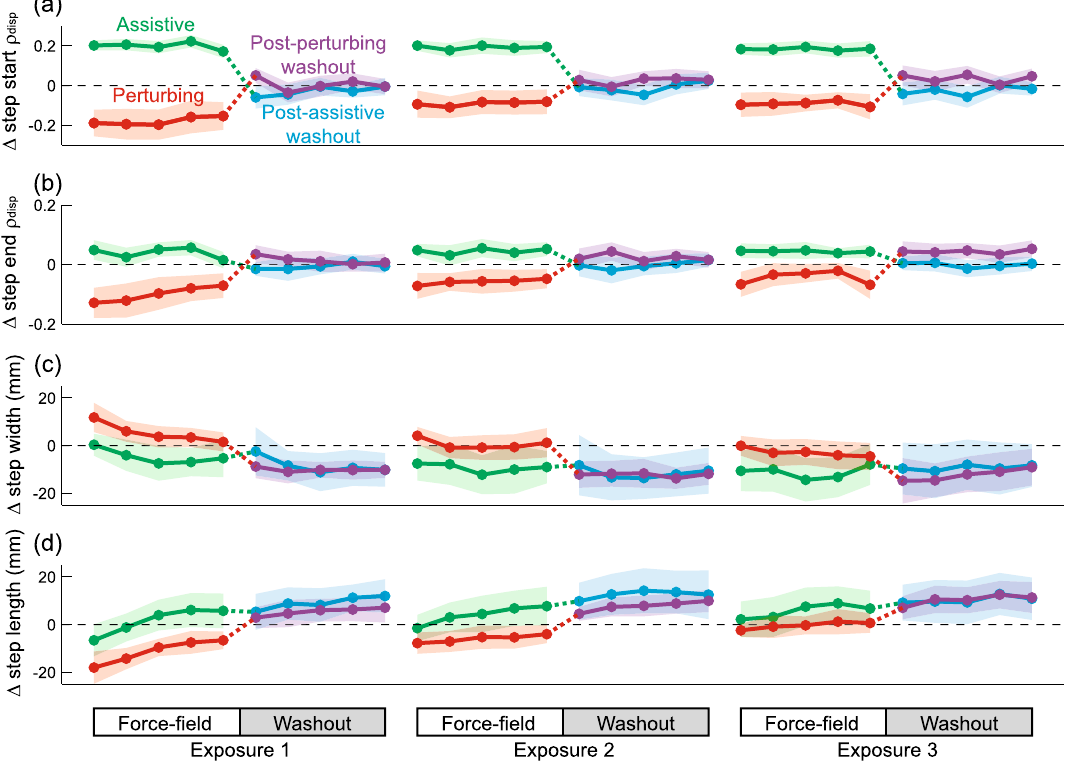
Figure 3. Gait behavior across three consecutive 10-min walking trials (exposures) that included either force- field assistance or perturbations. These changes are illustrated for step start ρ disp —the partial correlation between pelvis displacement and step width ( a ), step end ρ disp ( b ), step width ( c ), and step length ( d ), and are plotted in terms of the difference from the initial Transparent trial. Each data point represents the mean value calculated within each 45-step bin, and shaded areas indicate 95% confidence intervals. The dashed line at zero is presented to allow easier visualization of changes relative to the initial Transparent